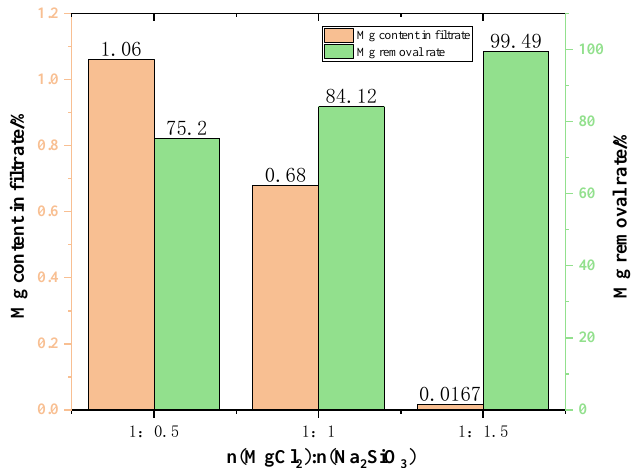
Figure 10. The effect of additive dosage on the Mg content in the filtrate and on the Mg removal rate.